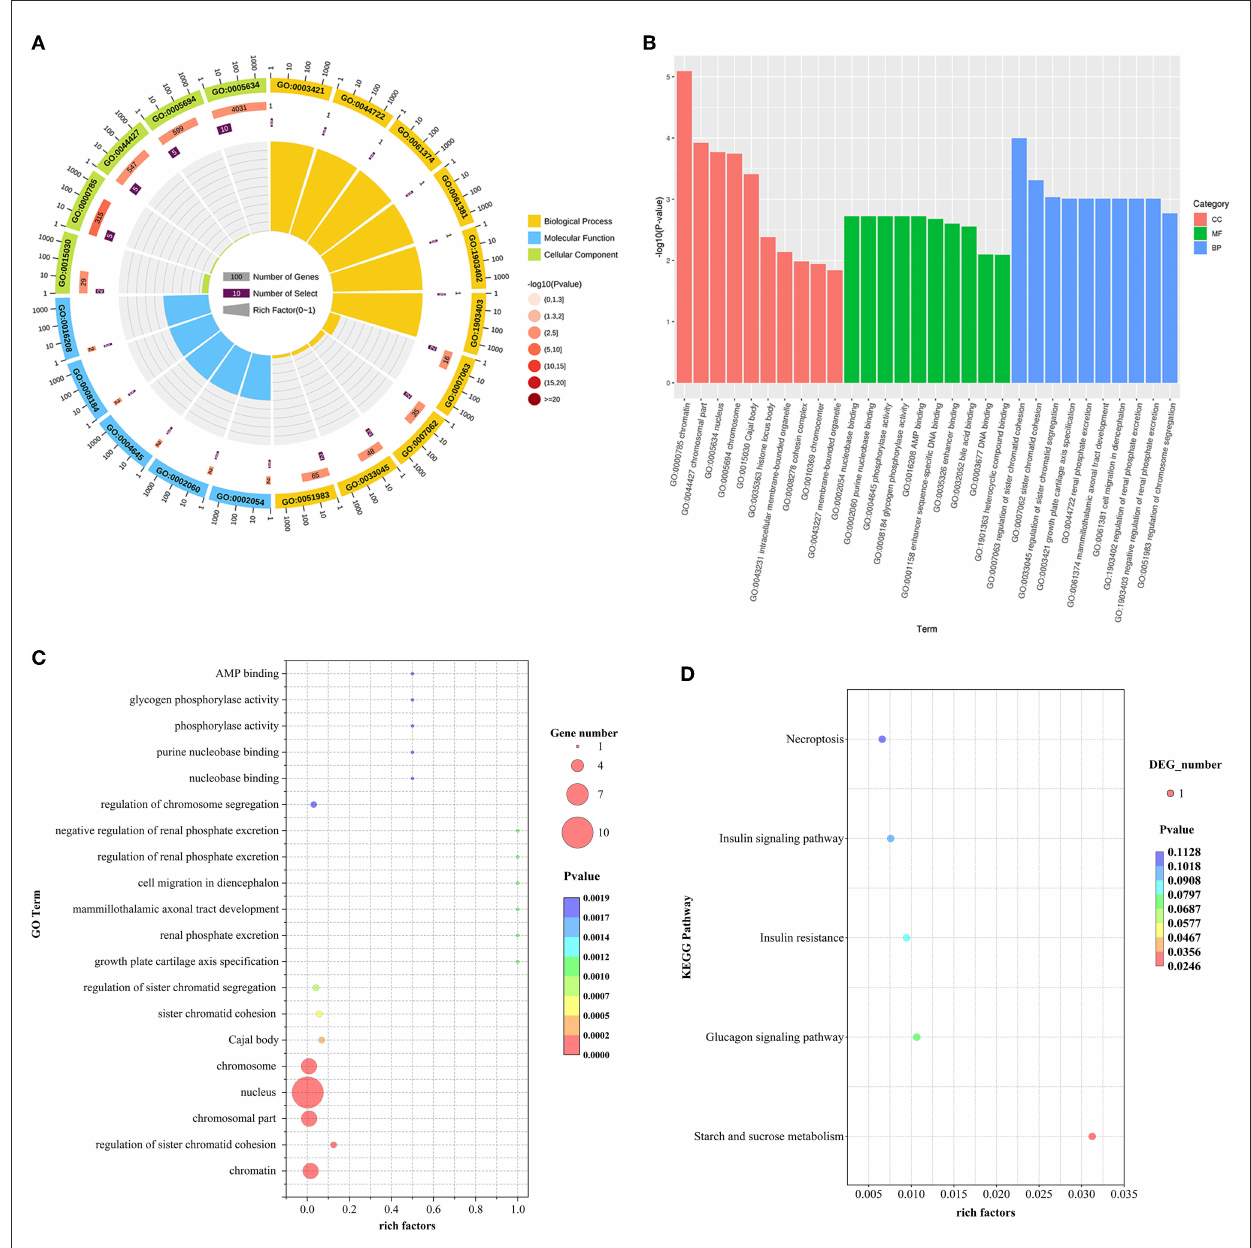
FIGURE2 (A–D) GO and KEGG analyses of DE lncRNAs between HFG and LFG in the hypothalamus.